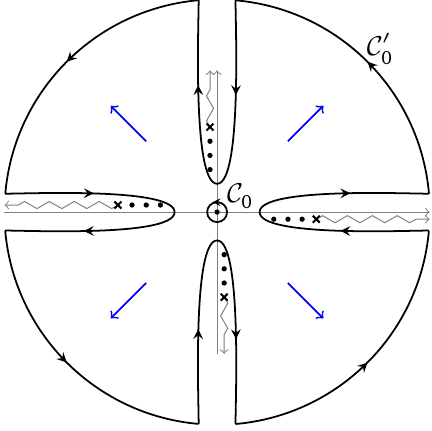
Figure 7: Contour deformation from C